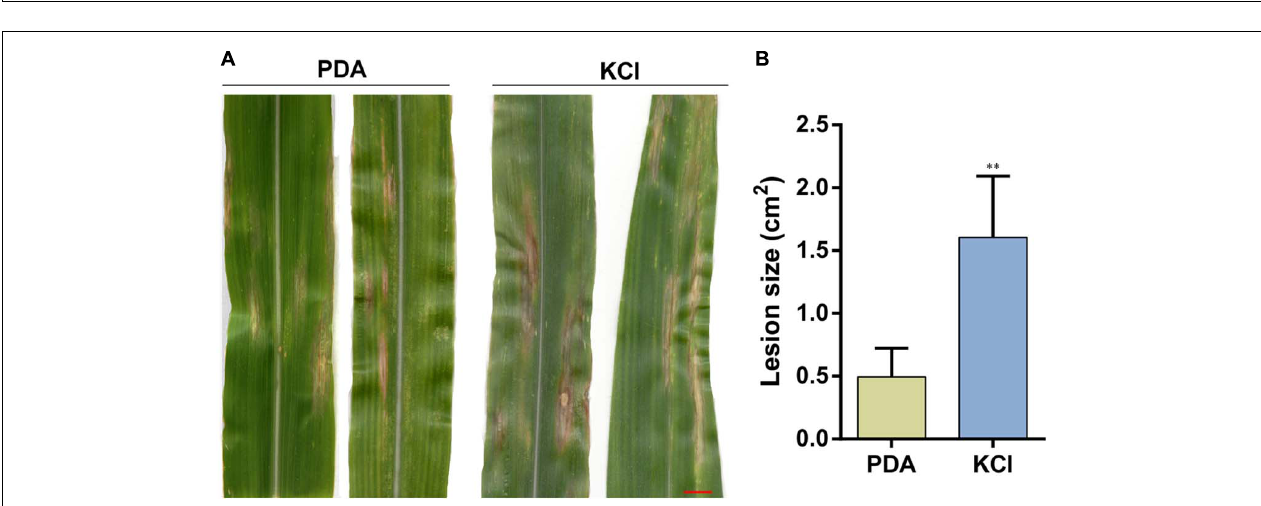
FIGURE 6 | Pathogenicity of S. turcica after 20 days of culture under the 0.4 M KCl and control (PDA). (A) Conidial suspensions were inoculated on maize B73 seedling whorl at the 4–6 leaf stage, and results were scored at 12 days post-inoculation and (B) the mean size of the lesion. ** P < 0.01, bar = 1